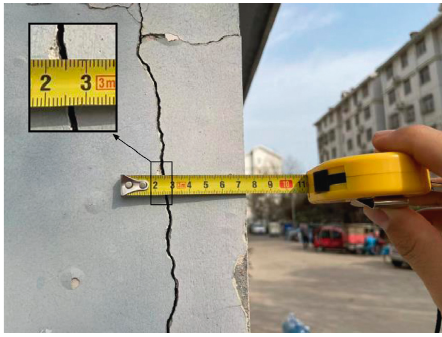
Figure 15: Cracks on the first floor of the masonry